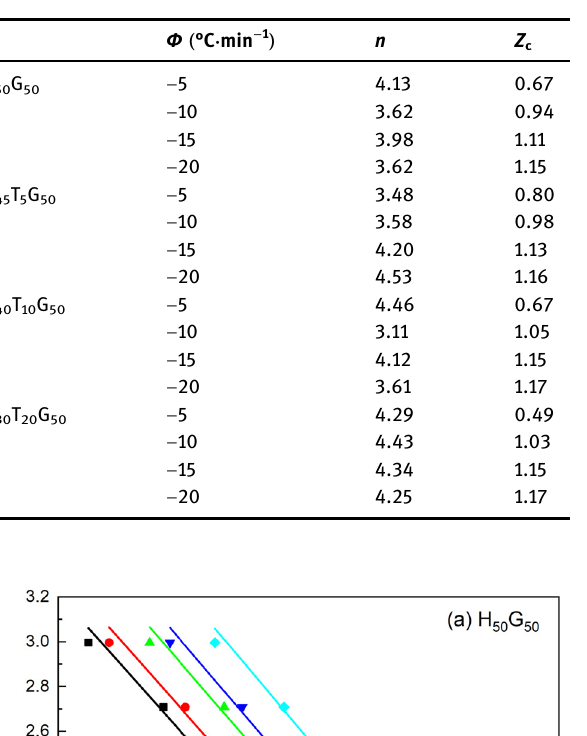
Table 4: The parameters of nonisothermal cooling crystallization for